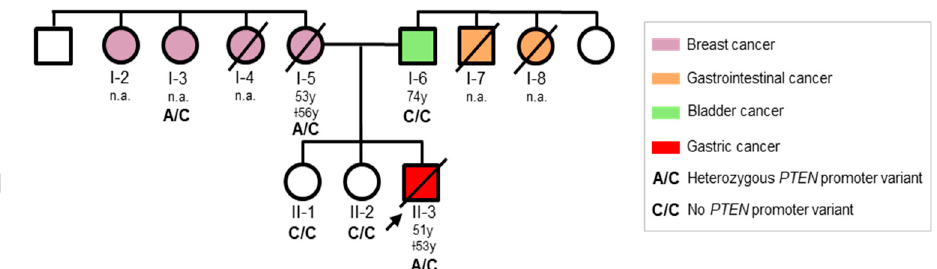
Figure 1. Pedigree of the family involved in this study. Squares indicate men, circles represent women. The arrow indicates the index patient. Unfilled symbols indicate unaffected individuals. Slashed symbols denote dead individuals. The following information is provided below each filled symbol: age at diagnosis (y = years; n.a. = not available), age at death (†).